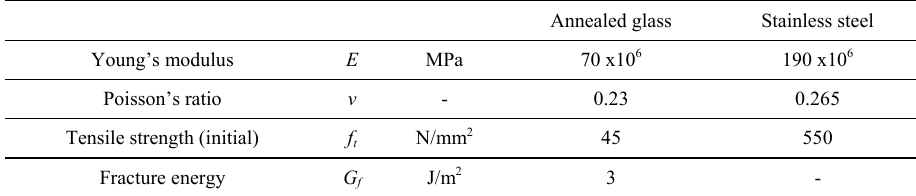
Table 1: Adopted material parameters for glass and stainless steel roughly based on [8, 9, 10].